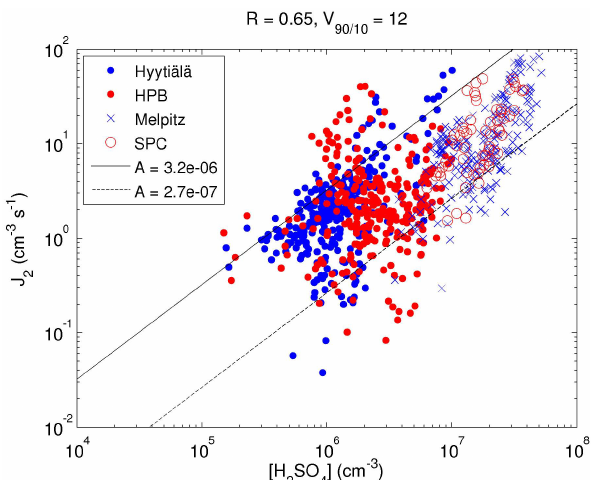
Fig. 5. Neutral particle formation rate J 2 as a function of squared sulphuric acid concentration separately for each measurement site. In the Hohenpeissenberg plot (upper right) the black points indicate the data recorded between April and July, whereas at the other sites all the data are from these months. The lines present the site-specific 90th and 10th percentile values of the kinetic coefficient K (Eq. 11), the values of which are presented in units (cm 3 s − 1 ) on the right hand